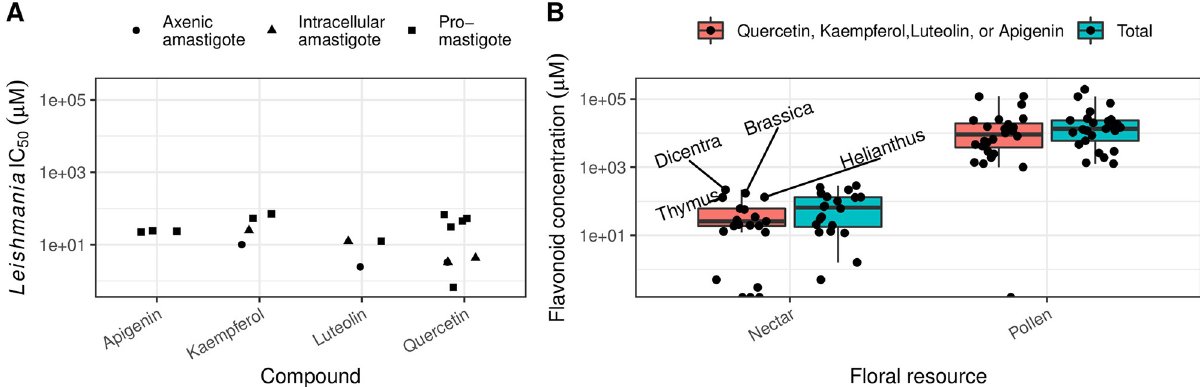
Fig 1. Published Leishmania IC50 estimates for selected flavonoids (A) relative to concentrations of the corresponding compounds in nectar and pollen (B). Shapes in panel (A) correspond to the Leishmania stage tested. Boxplots in panel (B) show medians and interquartile ranges for concentrations of quercetin, kaempferol, apigenin and luteolin derivatives (red boxes) and total flavonoids (blue boxes). Points show median concentrations (pooled across individual samples) by species. Text annotations denote species with > 100 μ M of the selected flavonoids in nectar ( Brassica napus , Dicentra eximia , Helianthus annuus , and Thymus vulgaris ). Literature references for Leishmania IC50 estimates are given in Table A in S1 Text.